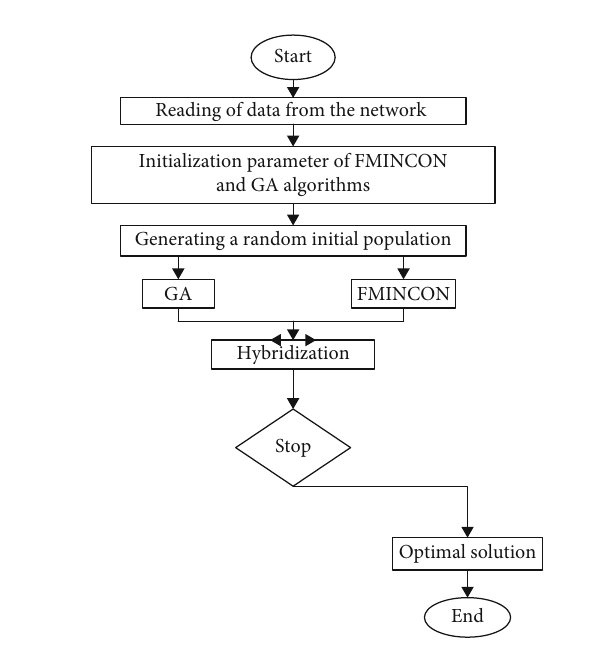
Figure 18: Flowchart of hybrid